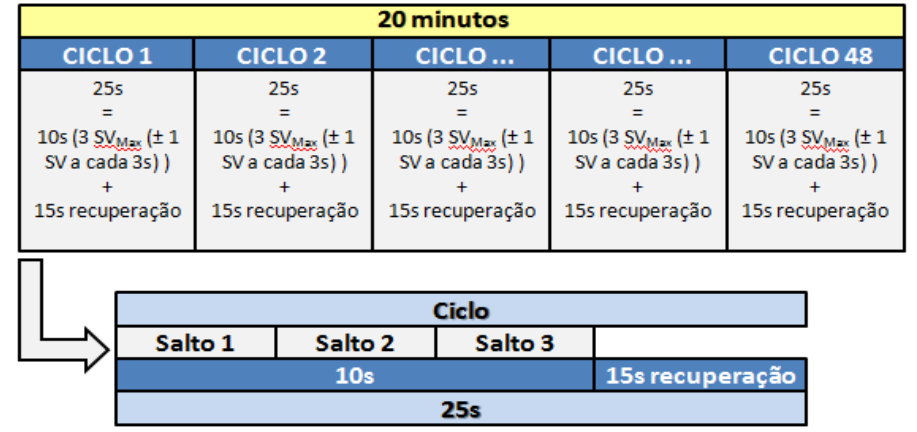
Figura 1. Esquema representativo do Protocolo de Resistência de Saltos